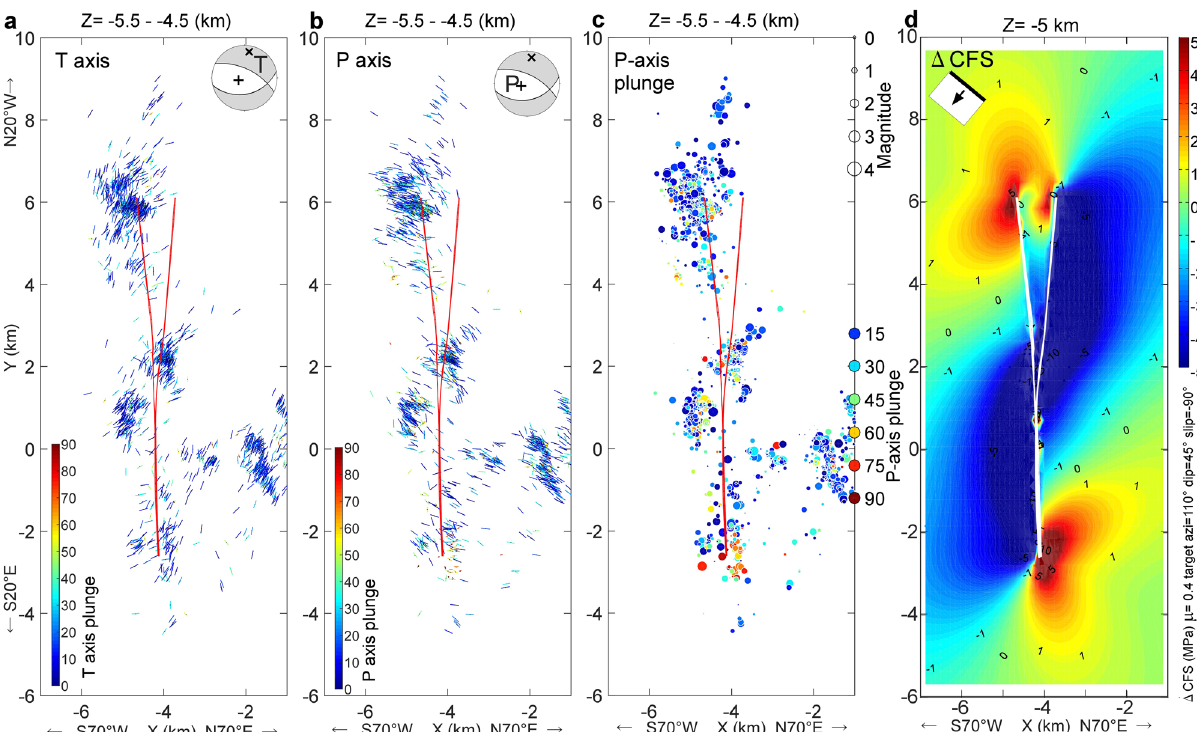
Fig. 3 Distributions of T and P axes and P axis plunge of optimal focal mechanism solutions and Δ CFS. a T (tension) axes of aftershocks located at depths of 5 ± 0.5 km projected onto the horizontal plane. Their plunges (i.e., angles measured from the horizontal) are indicated by colours from blue to red. The inset fi gure indicates the T axis on a focal mechanism solution. b P (pressure) axes. c P axis plunges; showing that normal faulting events have larger plunges. d Distributions of Δ CFS for normal faulting aftershocks with a fault strike of N110°E, a plunge of 45°, and a slip direction of − 90°. The grey and white beach balls of focal mechanism solutions indicate the orientations of T and P axes in ( a ) and ( b ). The inset rectangle in ( d ) indicates the fault plane on which Δ CFS is calculated. The upper edge and slip direction are shown by the bold line and arrow. Red and white lines indicate the estimated fault planes at this depth. The northern edge of the WF was set at Y = 6.1 km in this fi